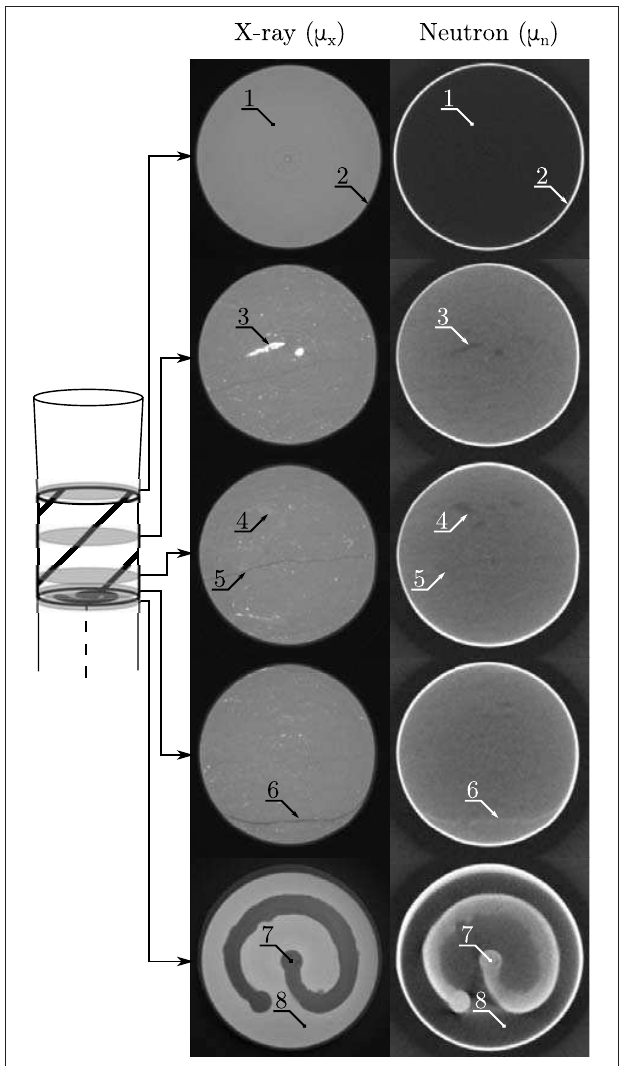
FIGURE 3 | Selected horizontal slices through registered µ x and µ n fields in state 002, highlighting the different phases in the material. The greylevels shown are [0–42,000] for µ x and [0–52,000] for µ n . As per convention, dark values in the slices represent lower values. 1. Aluminium top cap, 2. Latex membrane, 3. “Dense” inclusions, 4. “Less dense” inclusions, 5. “Dry” crack, 6. Water-filled crack, 7. Pure water, 8. Aluminium bottom cap.